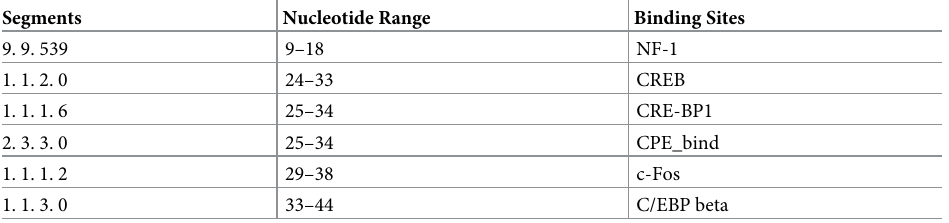
Table 4. AliBaba2 results tabulated to represent segments for the transcription factor binding sites and their nucleotide ranges in mutant IL-6 gene. Segments